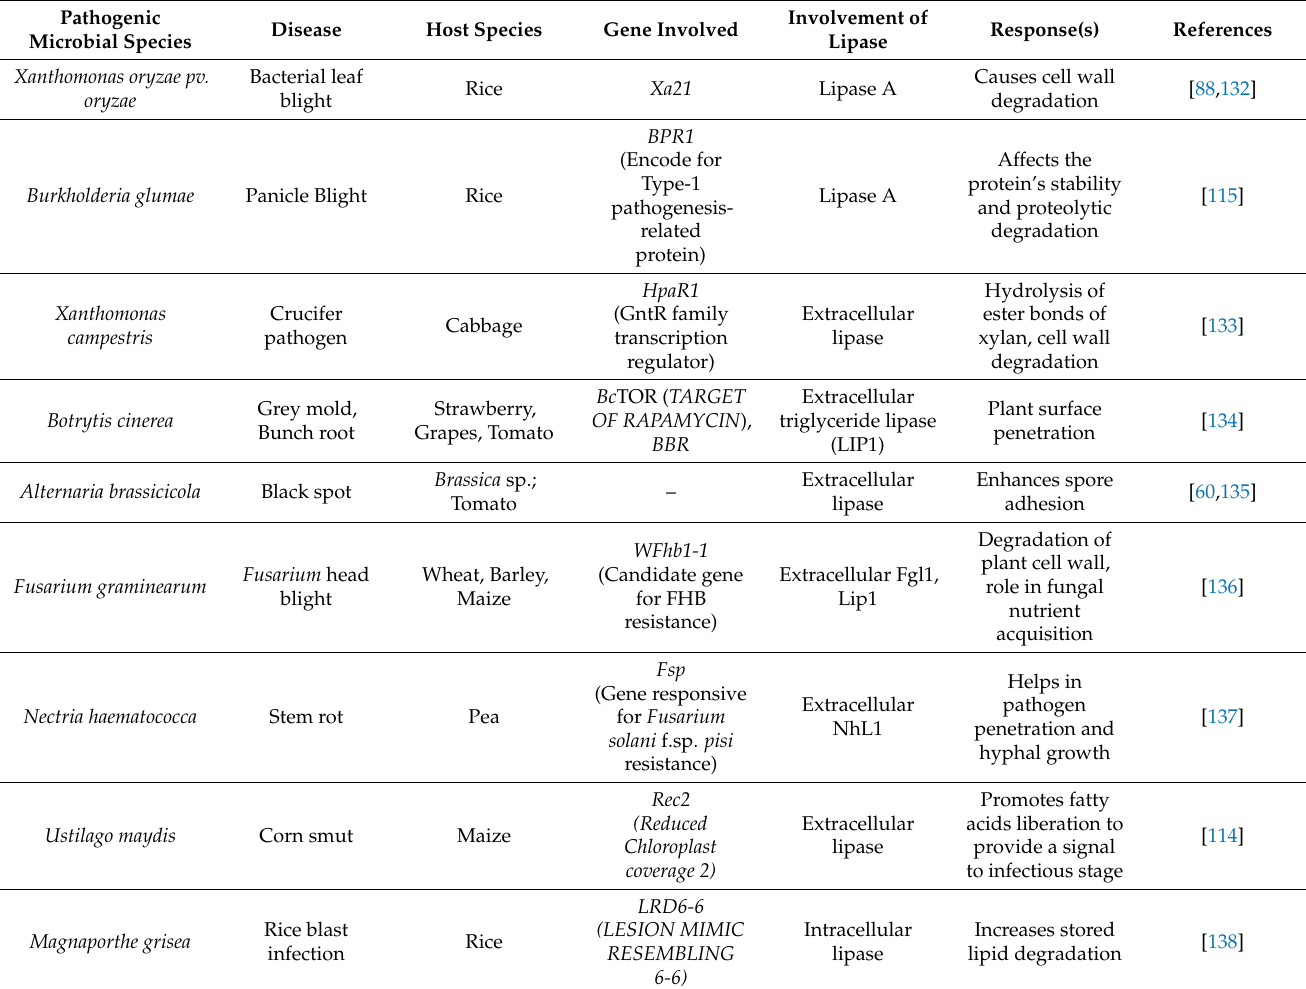
Table 3. Molecular regulation and response strategies of pathogens after a successful invasion in crop